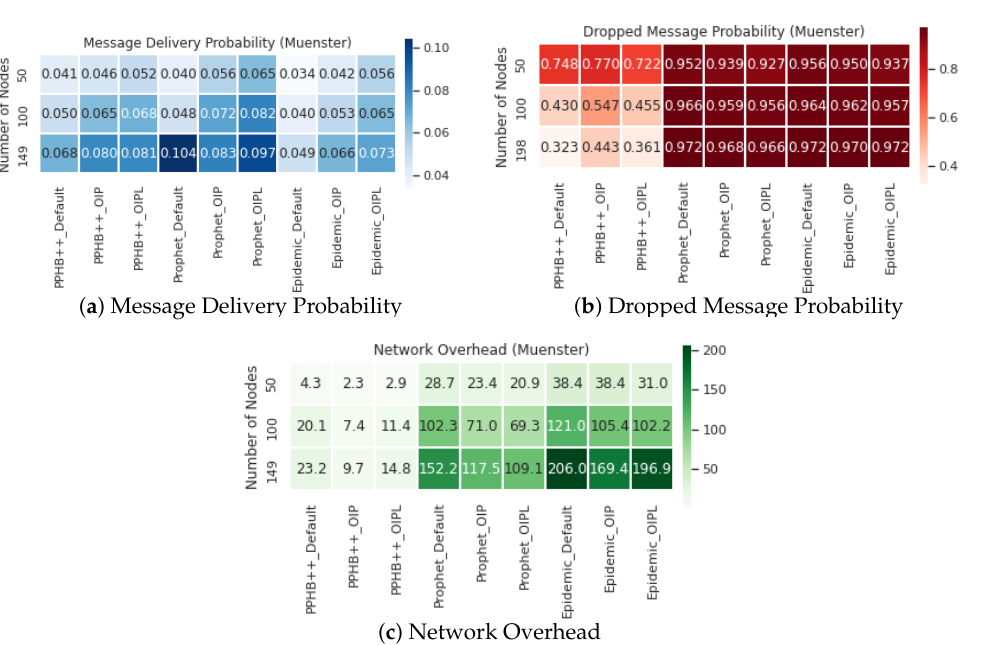
Figure 11. Comparison of ONE default setting with optimized parameters for Münster dataset (The MDP and DMP parameters are normalized to a scale between 0 and